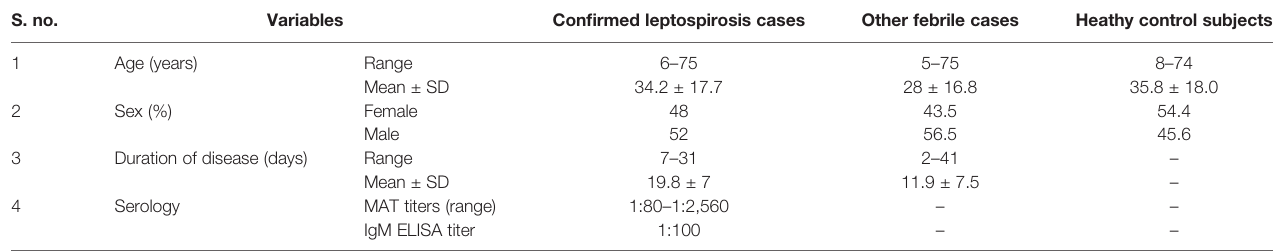
TABLE 1 | Demographic characteristics of the study